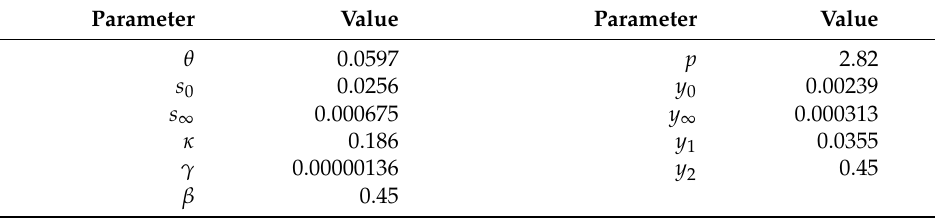
Table A1. PTW calibration for β -tin as in